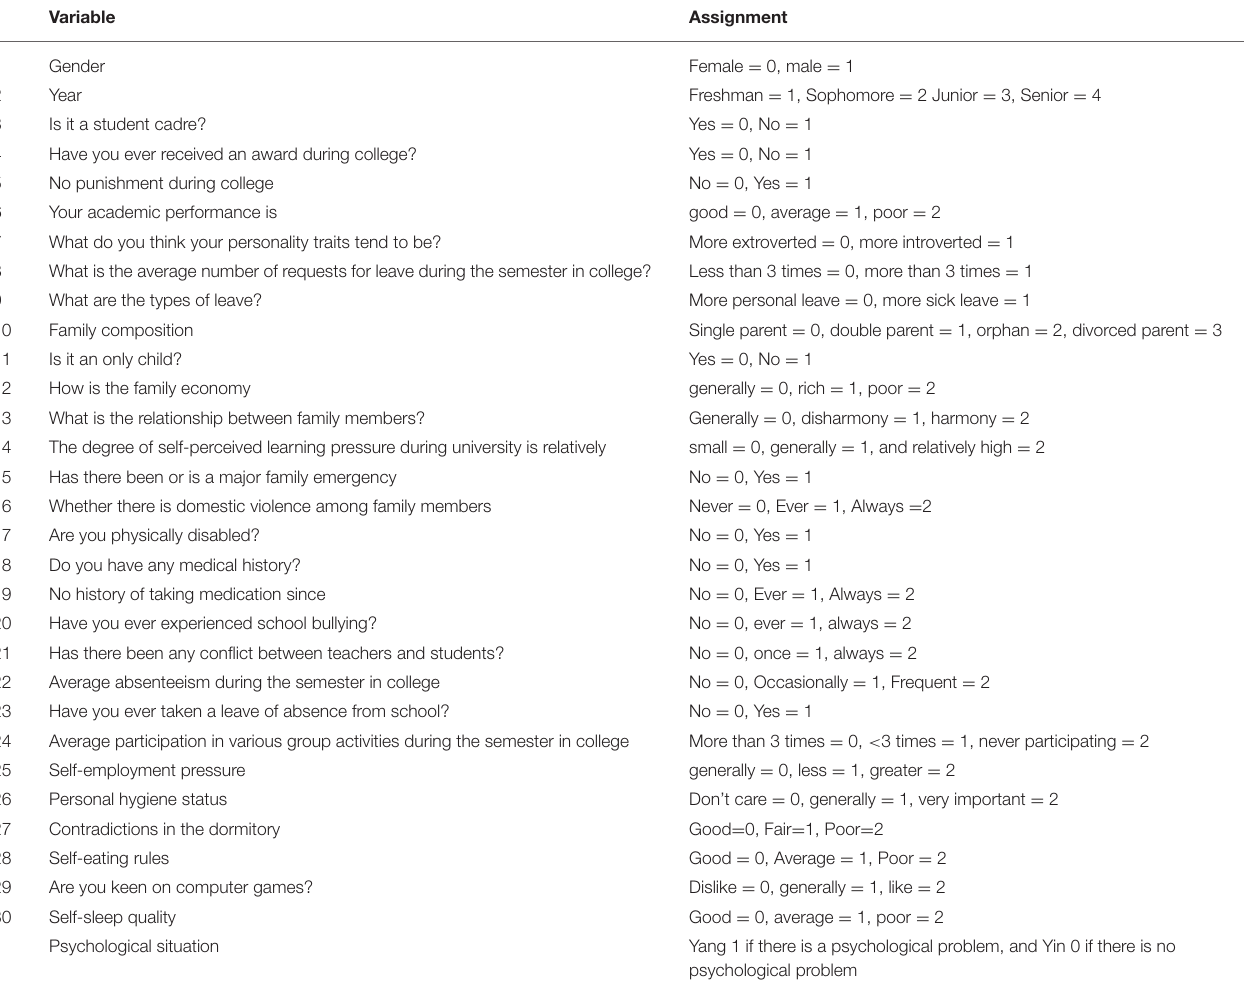
TABLE 1 | Questionnaire attribute assignment table.